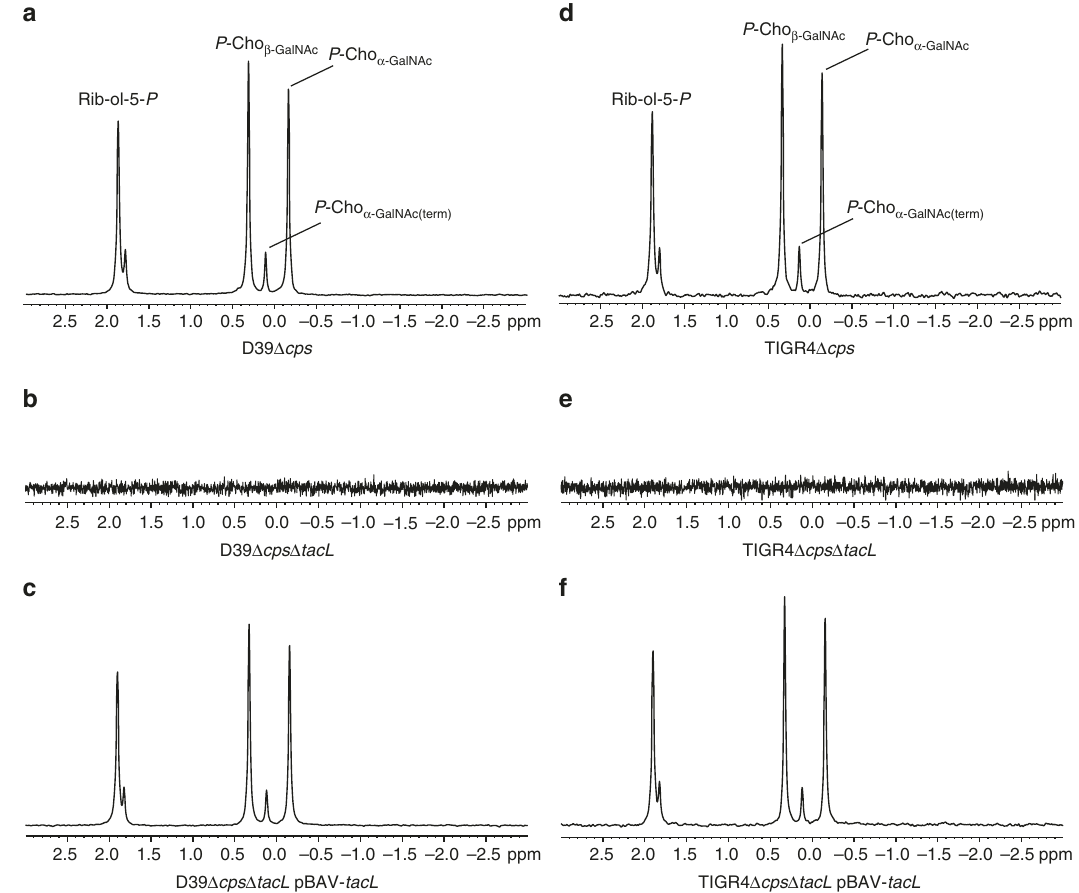
Fig. 2 31 P NMR spectra of pnLTA preparations. Sections ( δ P 3-( − 3)) of 31 P NMR spectra measured from LTA isolated from pneumococcal strains a D39 Δ cps , b D39 Δ cps Δ tacL , c D39 Δ cps Δ tacL pBAV- tacL , d TIGR4 Δ cps , e TIGR4 Δ cps Δ tacL , and f TIGR4 Δ cps Δ tacL pBAV- tacL . a , c , d , f